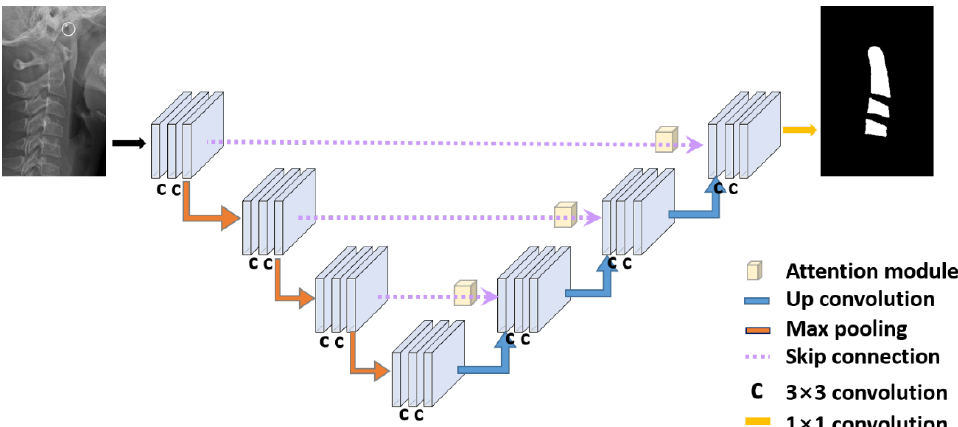
Figure 3. The architecture of the segmentor module. The cropped ROI image is input in this module, and the output is a cervical vertebrae segmentation image. The main network is attention U-Net.